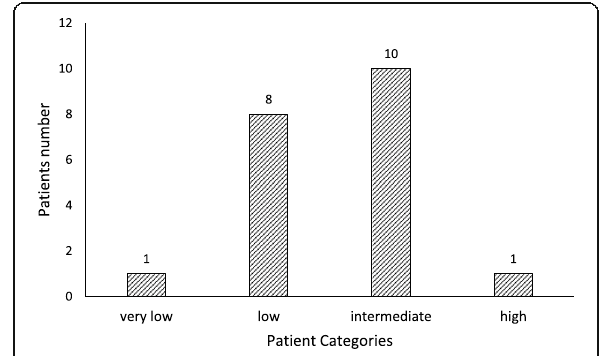
Fig. 2 The patient ’ s classification according to RT-PCR values and virus titers. Very low ≤ 10,000; low 10,000:100,000; intermediate